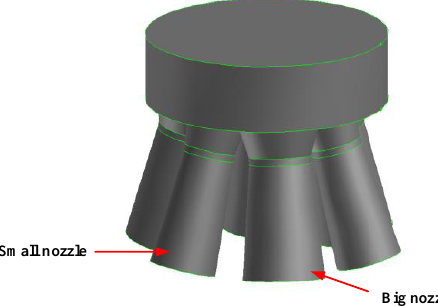
Figure 5. Schematic diagram of a double-parameter oxygen lance.